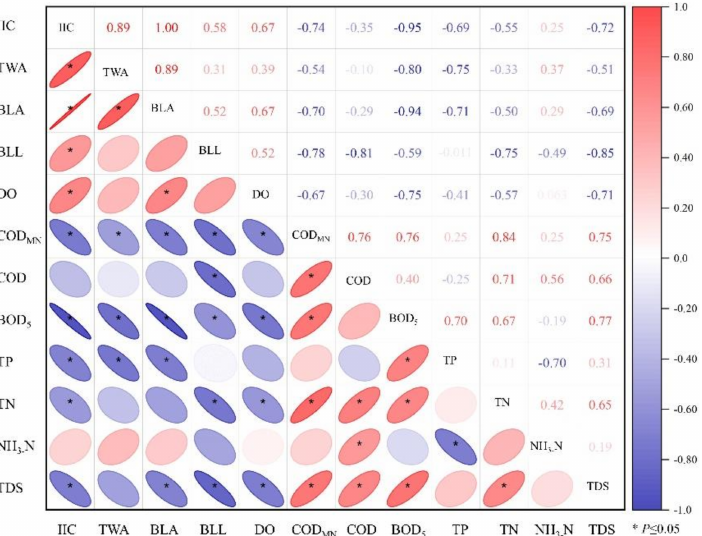
Figure 8. Correlation test of each index. IIC: integral index of connectivity; TWA: total water area; BLA: Bosten Lake area; BLL: Bosten Lake